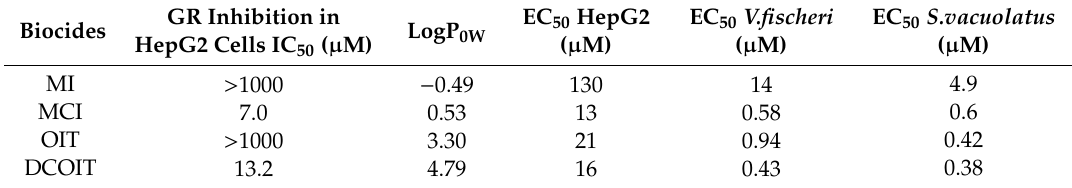
Table 3. Calculated IC 50 for MI, MCI, OIT, and DCOIT using glutathione reductase (GR) inhibition assay. Experimental LogP ow and experimental EC 50 observed in three cellular models (HepG2, Vibrio fischeri , and Scenedesmus vacuolatus )